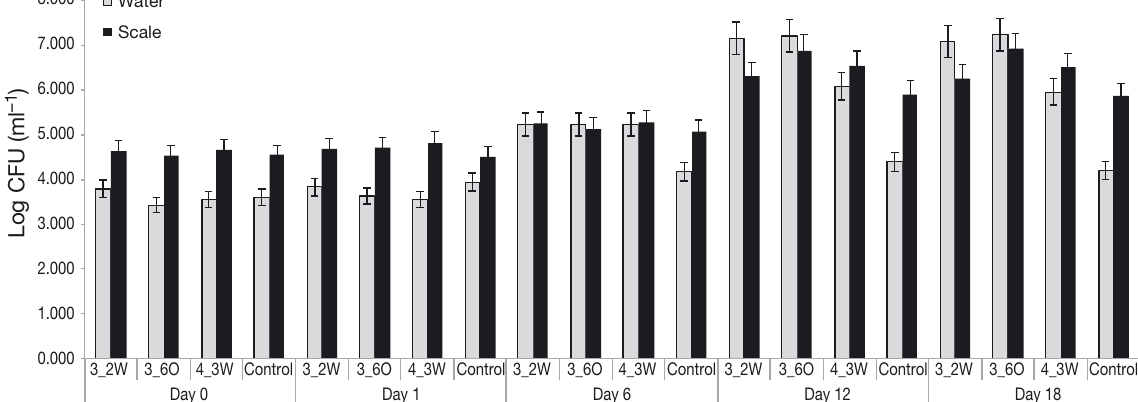
Fig. 2. Amount of bacteria (CFU ml −1 ; mean ± SE) in the water of the experimental tank (grey bars) and scale swabs from the dorsal area (black bars) of brown-marbled grouper fingerlings treated for 12 d with the surface-associated bacteria Vibrio harveyi (3_2W), Exiguobacterium acetylicum (3_6O), or Psychrobacter sp. (4_3W). The control tank received marine